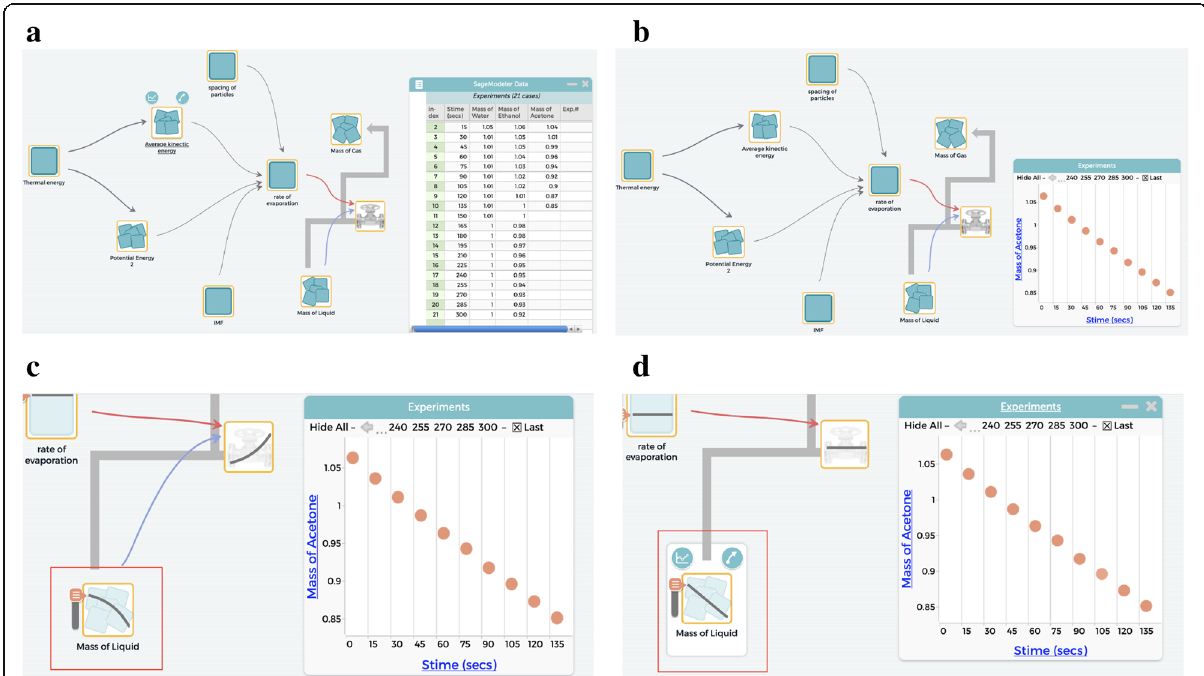
Fig. 8 Using models to predict novel phenomena and to validate models with experimental data for making iterative refinements. a Model with experimental data. b Graph from experimental data. c Graph from simulated output (in red box). d Revised Model with simulated graph (in red